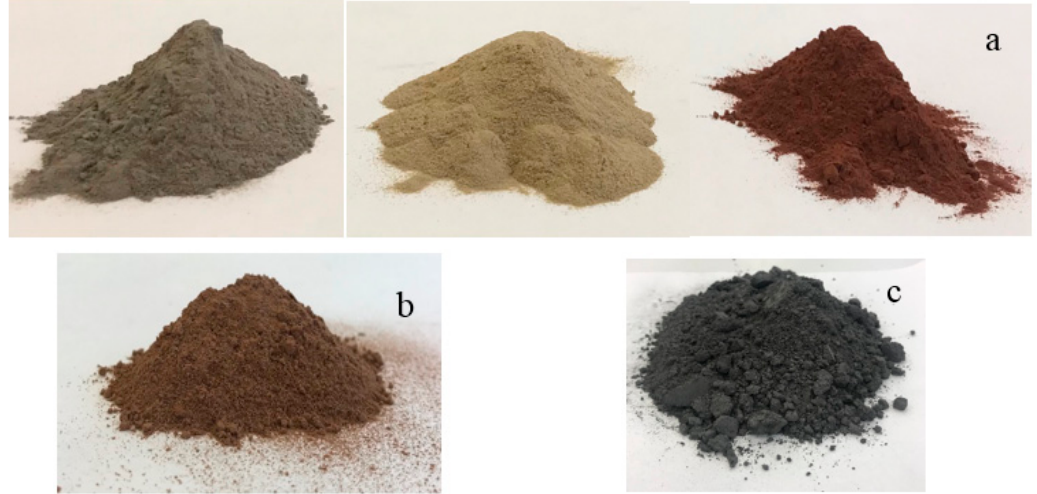
Figure 1. Photos of ( a ) the black, yellow, and red clay, ( b ) the clay mixture used as raw material, and ( c ) the aluminum filter dust waste (AFD).